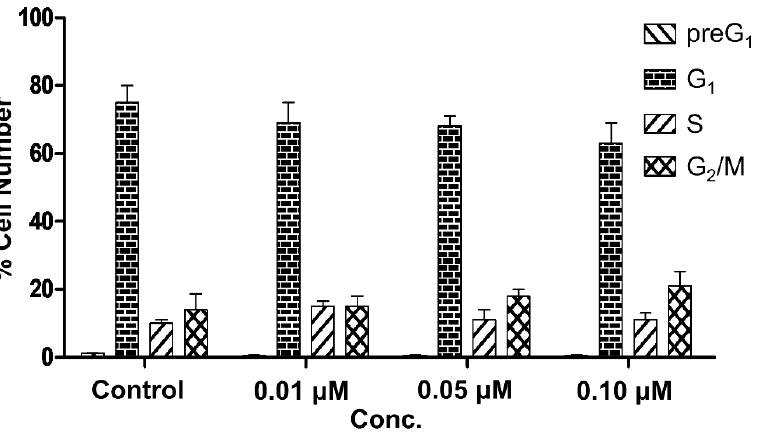
Figure 12. A bar chart showing the effects of compound 16g on cell cycle distribution after 72 h treatment of MCF-7 cells with 0, 0.01, 0.05, and 0.10 μ M. ( n = 3).